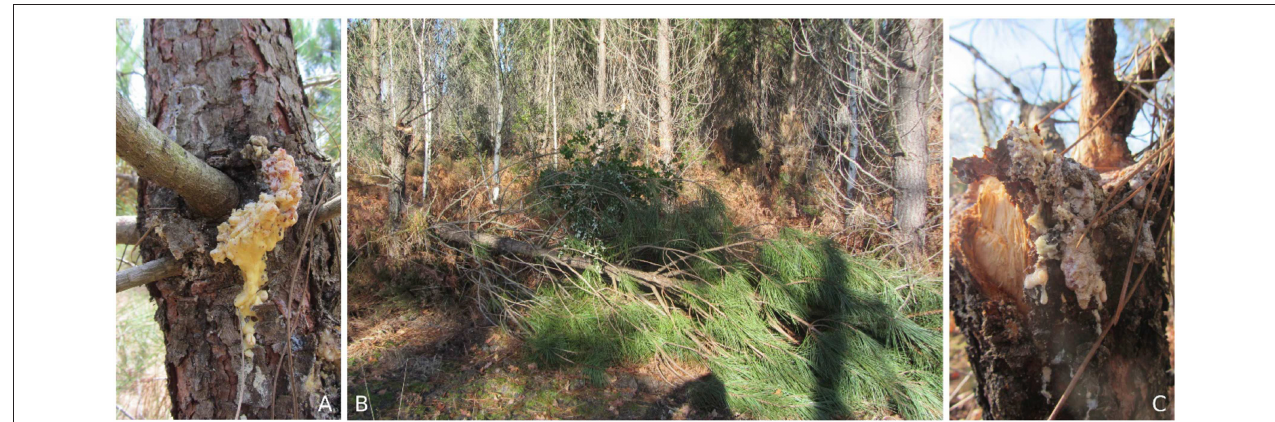
FIGURE 1 | (A) Fresh pralin of resin signaling the presence of a pine stem borer ( Dioryctria sylvestrella ) attack. (B) Maritime pine tree attacked by the stem borer and then broken by the wind. (C) Close-up on the breakage point where the larval gallery of D. sylvestrella was located (background), and on the distinctive pralin of resin mixed with insect frass